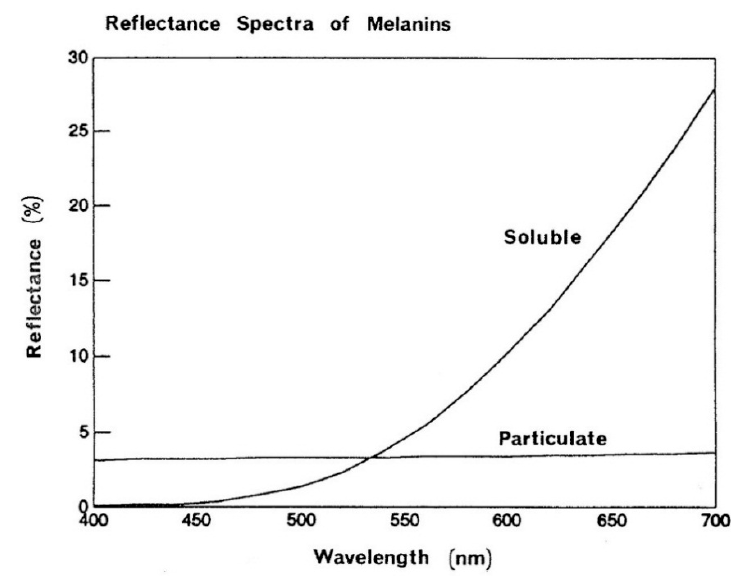
Figure 20. Reflectance Spectra of Melanins, adapted from Wolfram et al. [4], with permission from Society of Cosmetic Chemists, 1987.